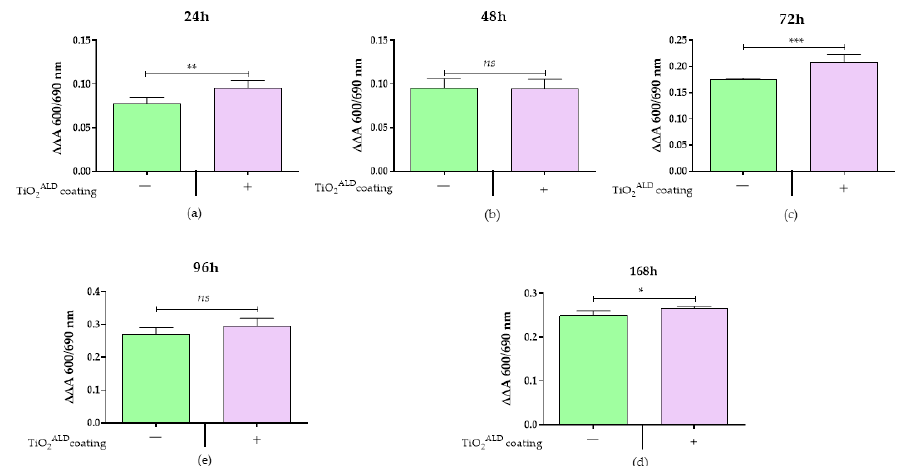
Figure 7. The metabolic activity in the control culture (TiO 2 ALD coatings-) and a culture propagated on TiO 2 . coatings (TiO 2 ALD coatings +; experimental culture): comparative analysis of metabolic activity after ( a ) 24 h, ( b ) 48 h, ( c ) 72 h, ( d ) 96 h, and ( e ) 168 h of propagation. (significant differences are marked with asterisks (*** p < 0.001; ** p < 0.01; * p < 0.05), non-significant results are marked as ns).